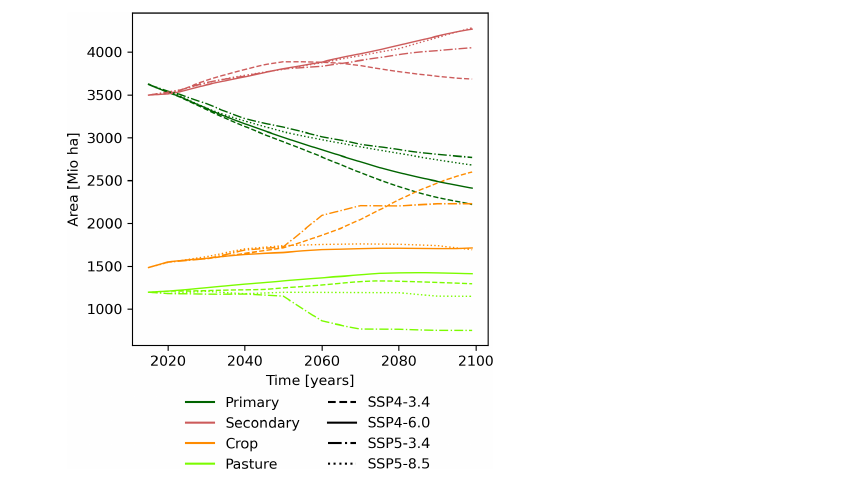
https://doi.org/10.5194/esd-12-763-2021 Earth Syst. Dynam., 12, 763–782,